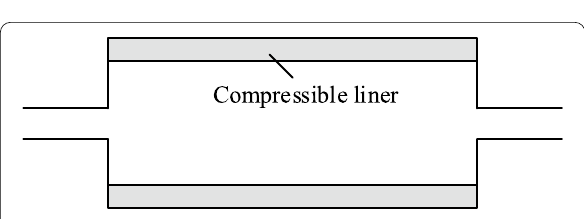
Figure 16 Expansion chamber pulsation attenuator based on compressible liner